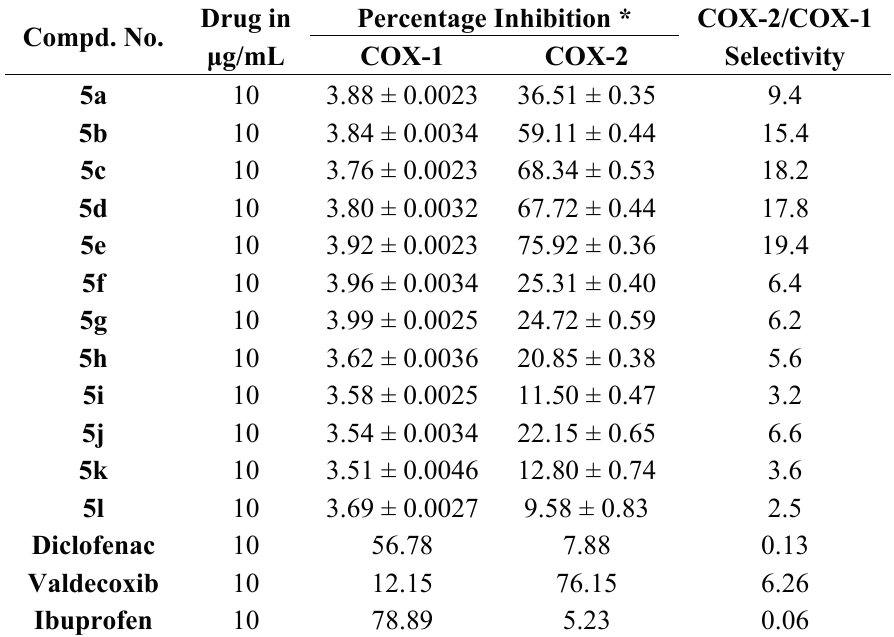
Table 1. Cyclooxgenanse (COX-1 and COX-2) inhibitory